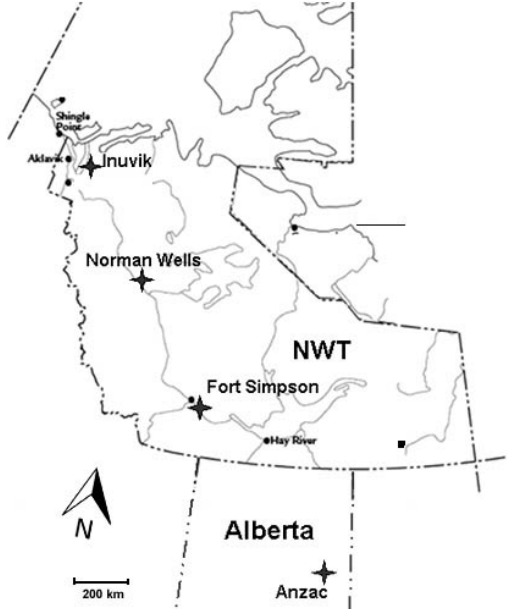
Figure 1. Map of the site locations.